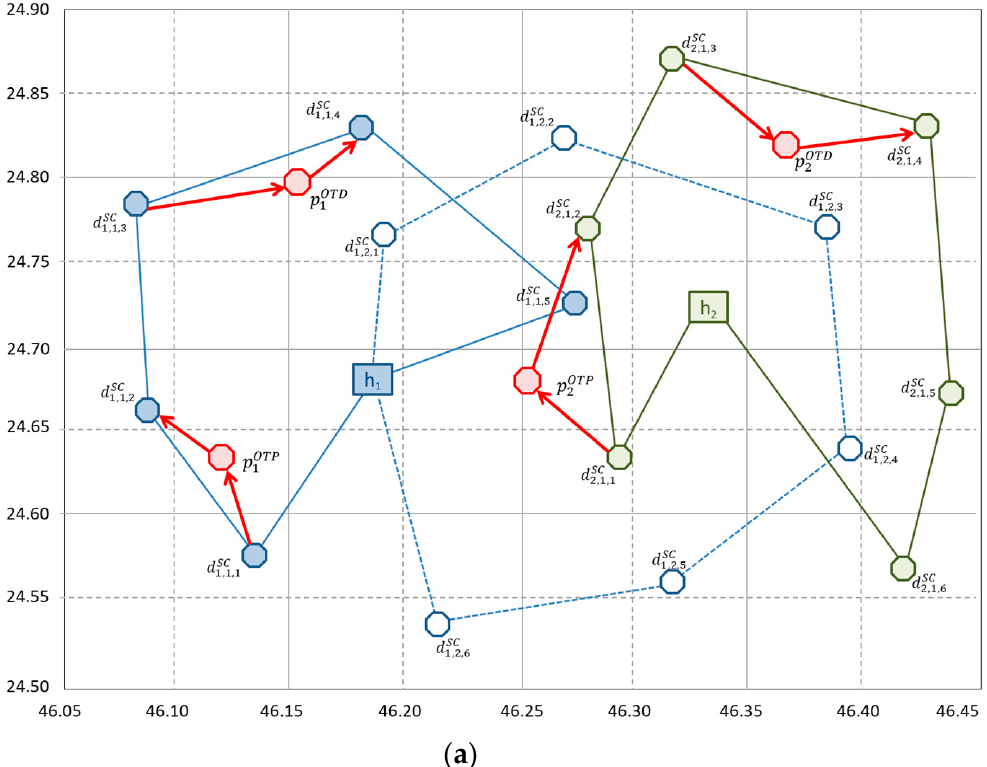
Figure 15. Loading capacities of delivery trucks after rescheduling. The initial loadings are the loading volumes in the h1 and h2 hubs: 170 pcs; 150 pcs; and 140 pcs. ( a ) Loading capacity of delivery truck assigned to route 1 after rescheduling; ( b ) Loading of delivery truck assigned to route 2 after rescheduling; ( c ) Loading capacity of delivery truck assigned to route 3 after rescheduling.